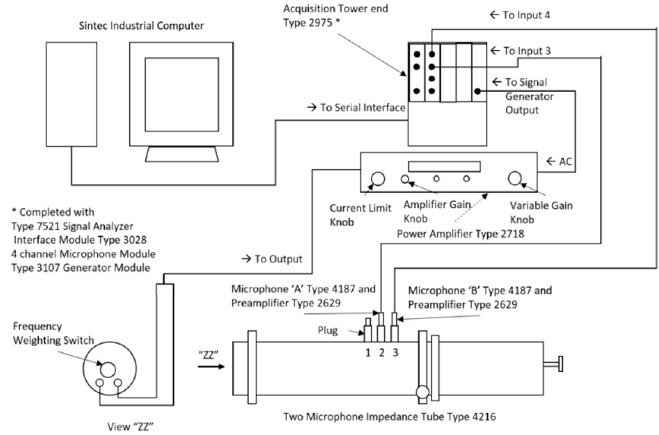
Figure 11. Various types of materials tested.